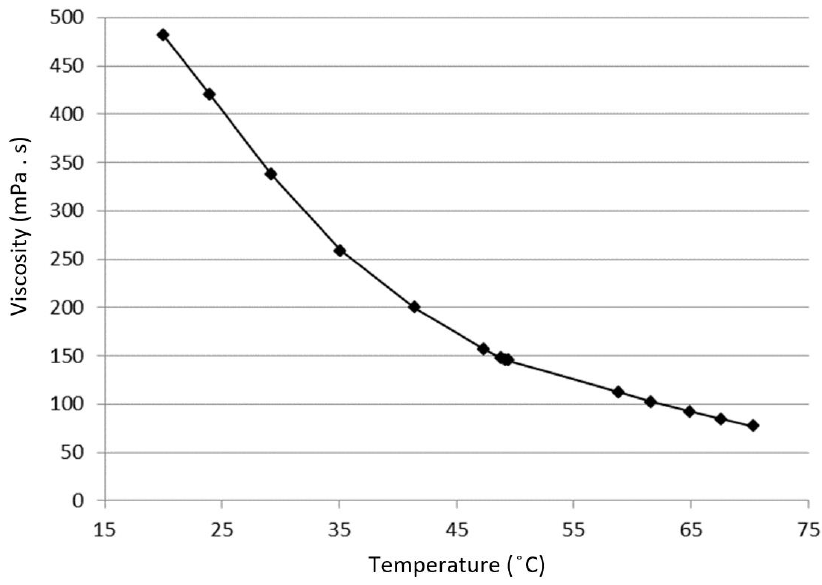
Figure 2. Initial oil viscosity depending on temperature.